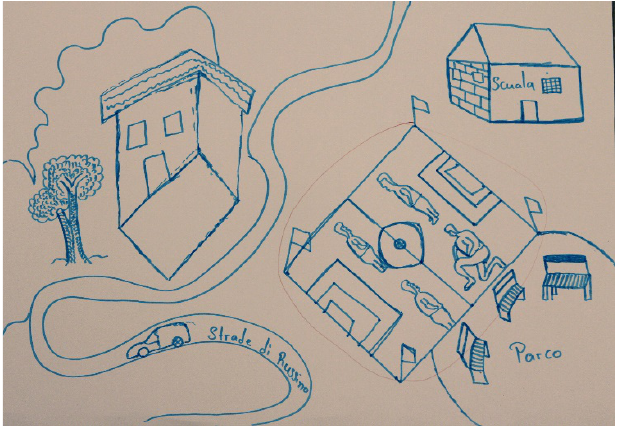
Figure 1 : Lamin’s drawing (workshop with